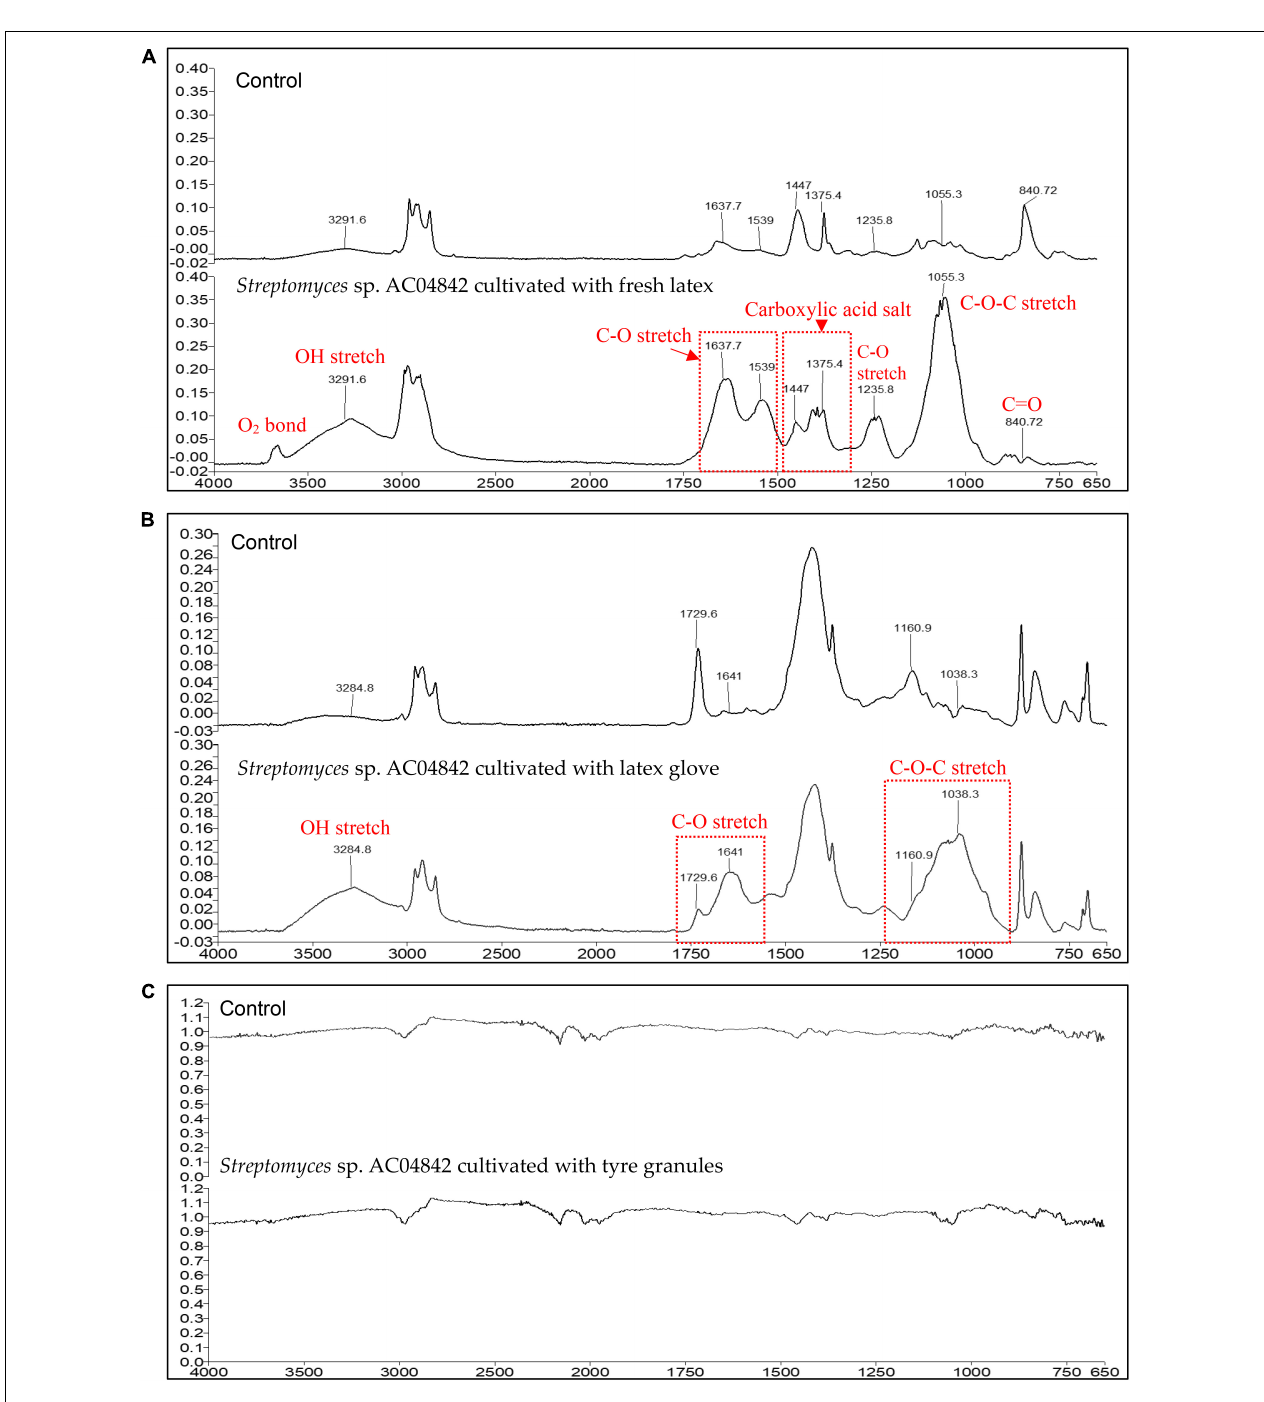
FIGURE 7 | ATR-FTIR profile for (A) fresh latex pieces, 5 mg; (B) latex glove strips, 1 mg; and (C) tire granules, 2 mg, as carbon source in MSM broth for 60 days at 28 ◦ C and 180 rpm. ATR-FTIR Spectrum 400 (Perkin Elmer), equipped with ATR ranging from 4,000 to 650/cm (4/cm resolution). Changes in peak profile compared with control are recorded as changes in the presence of functional groups (red fonts) as an indication of rubber polymer biodegradation.